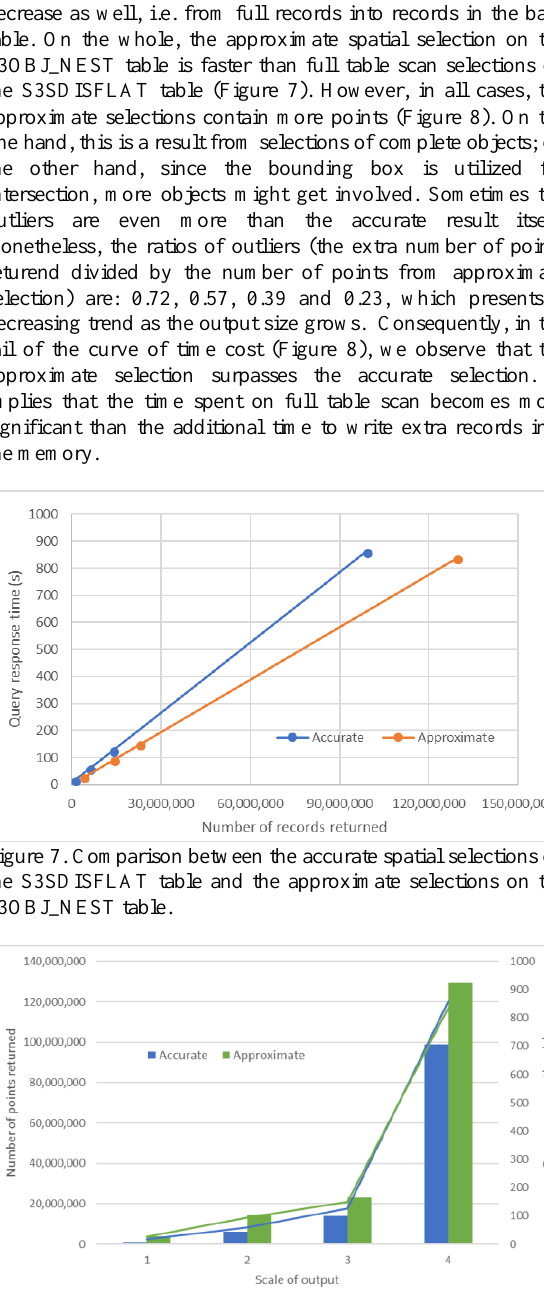
Figure 8. Comparison of the number of points returned from spatial selections on the S3SDISFLAT table presented as bars and the S3OBJ_NEST table, together with the query execution cost expressed using curves.